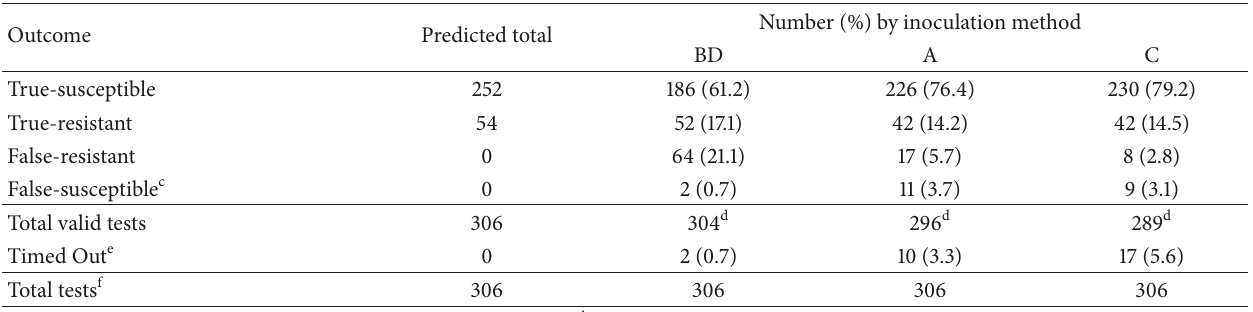
Table 2: Compiled PZA results for 14 susceptible and 3 resistant isolates a tested in duplicate by 9 laboratories b . Outcome